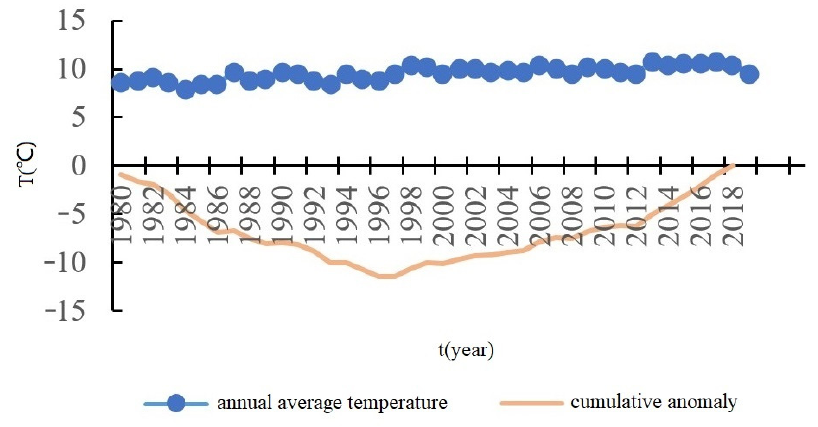
Figure 4. Average temperature and cumulative anomaly in the northern Ningxia Yellow Diversion Irrigation Area.